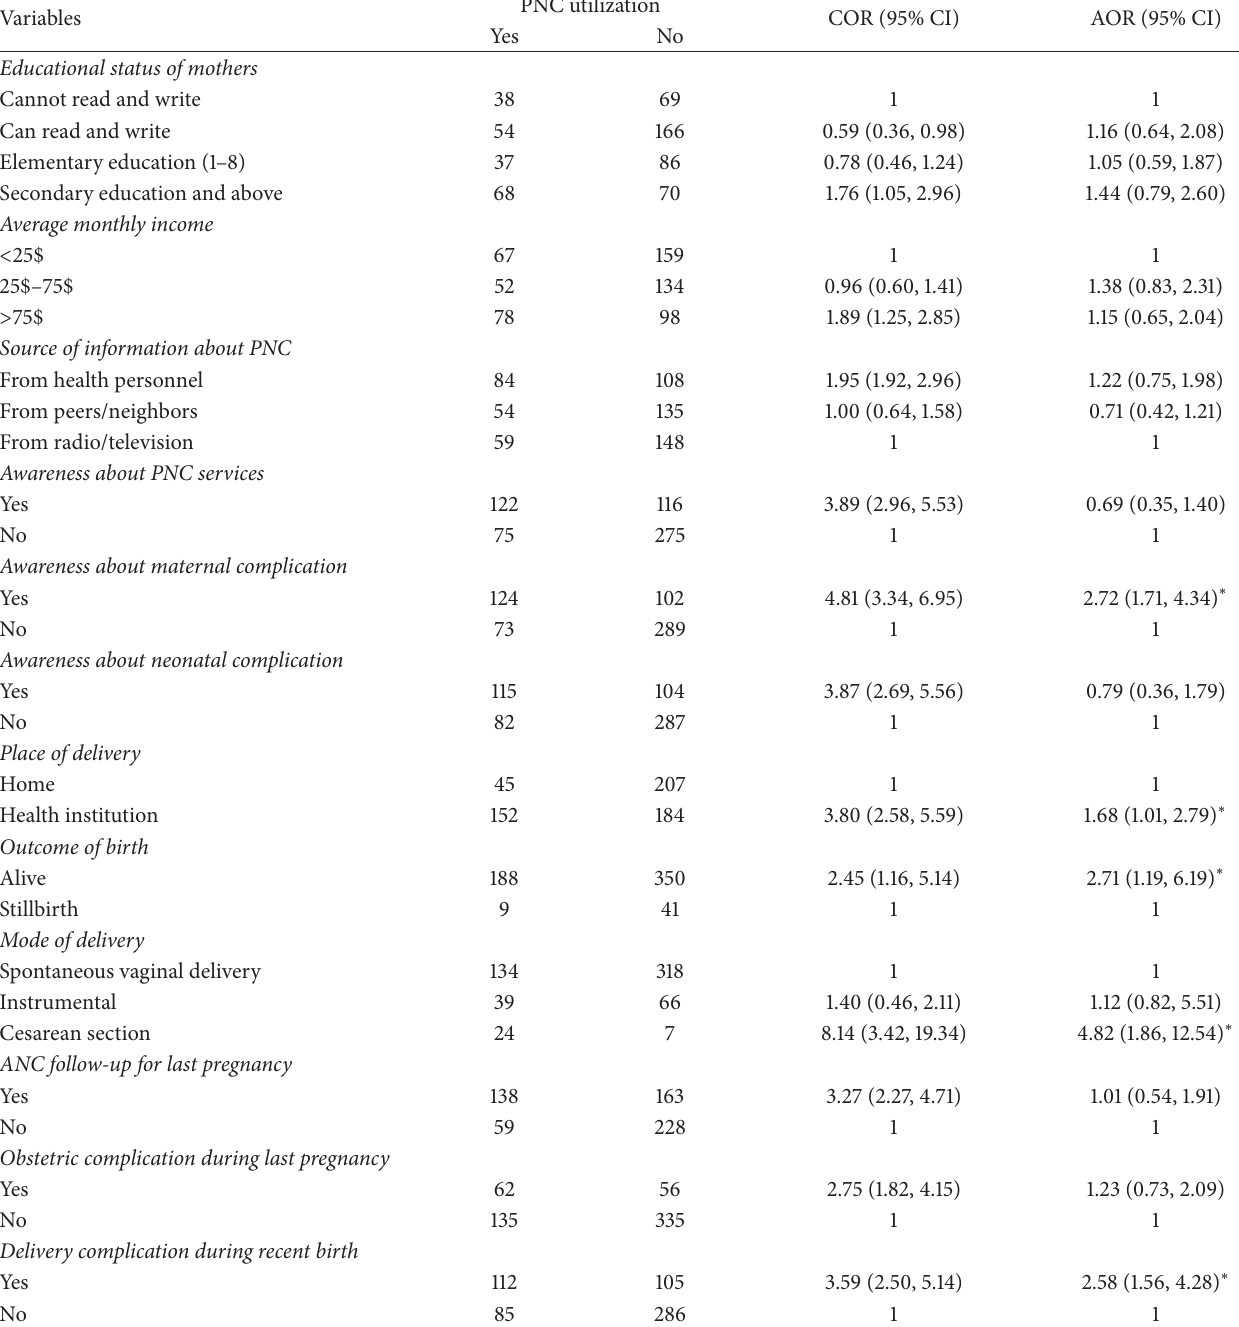
Table 3: Bivariate and multivariable analysis of factors associated with PNC utilization among the study participants at Debremarkos town, December, 2014 ( 𝑛 = 588